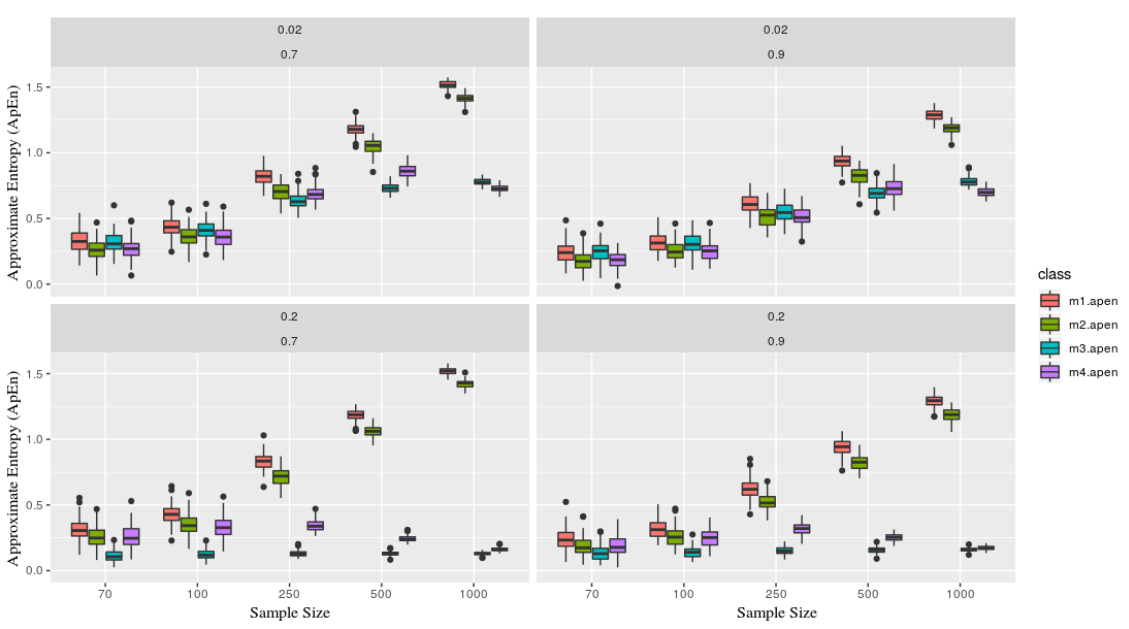
Figure 3. Each figure represents a simulated series, which contains two parameters γ = 0.02,0.2 and φ = 0.7,0.9 (in the top of each board). Each class (color) is associated with a given model, where as the sample size (x-axis), and y-axis the Approximate Entropy statistic. Models x1 and x2 are presents more stochastic components than x3 and x4, now recognize based on its entropy, especially as the sample size grows (showing stability). That is, x1 and x2 gets close to 1, meaning the is predominately originated from a stochastic